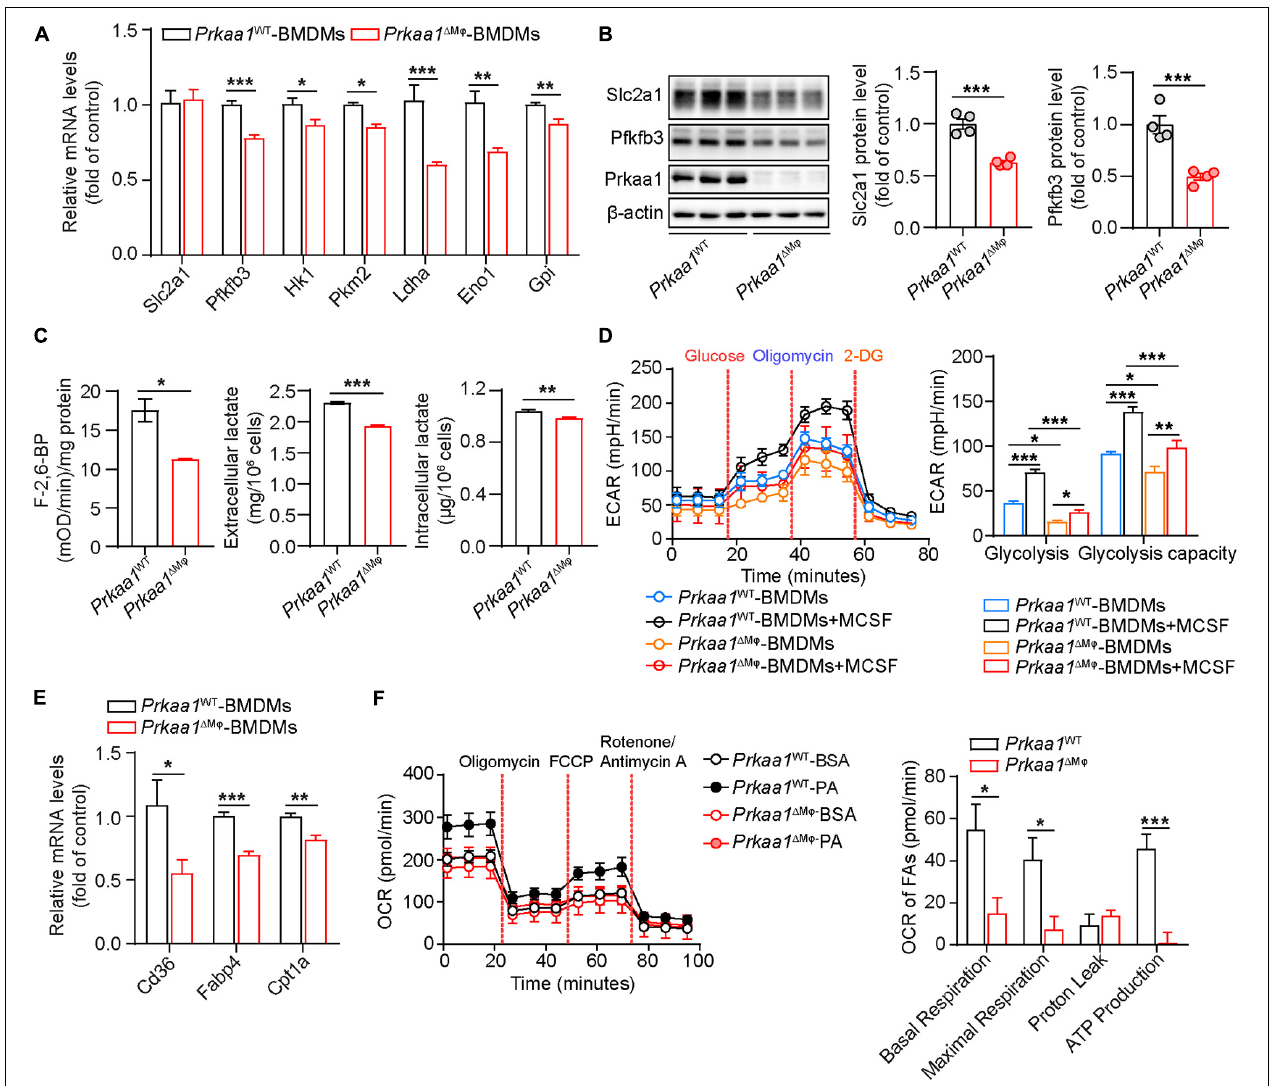
FIGURE 2 | Prkaa1 regulates macrophage glycolysis and fatty acid oxidation. (A) Real time-PCR analysis and quantification of mRNA levels of Slc2a1 , Pfkfb3 , Hk1 , Pkm2 , Ldha , Eno1, and Gpi in BMDMs cultured from Prkaa1 WT and Prkaa1 (cid:49) M ϕ mice. n = 4. (B) Western-blot analysis and quantification of protein levels of Slc2a1, Pfkfb3, and Prkaa1 in BMDMs cultured from Prkaa1 WT and Prkaa1 (cid:49) M ϕ mice. n = 4. (C) Measurement of F-2,6-BP, intracellular and extracellular lactate in BMDMs cultured from Prkaa1 WT and Prkaa1 (cid:49) M ϕ mice. n = 6. (D) ECAR profile showing glycolytic function and quantification of glycolytic function parameters in BMDMs cultured from Prkaa1 WT and Prkaa1 (cid:49) M ϕ mice under control and MCSF (20 ng/mL, 12 h) treatment. Dash lines indicate the time of addition of glucose (10 mM), oligomycin (1 µ M), and 2-DG (50 mM). n = 12 for each treatment group, repeated four times. (E) Real time-PCR analysis and quantification of mRNA levels of Cd36 , Fabp4 , and Cpt1a in BMDMs cultured from Prkaa1 WT and Prkaa1 (cid:49) M ϕ mice. n = 4. (F) OCR profile showing fatty acid oxidation and quantification of function parameters in BMDMs cultured from Prkaa1 WT and Prkaa1 (cid:49) M ϕ mice under BSA-palmitate treatment. Etomoxir (Eto, 40 µ M) was added to some wells 15 min prior to the assay. n = 12 for each treatment group, repeated four times. All data are expressed as mean ± SEM. Statistical significance was determined by unpaired Student’s t -test and one-way ANOVA followed by Bonferroni test. * p < 0.05 was considered significant, ** p < 0.01, and *** p <